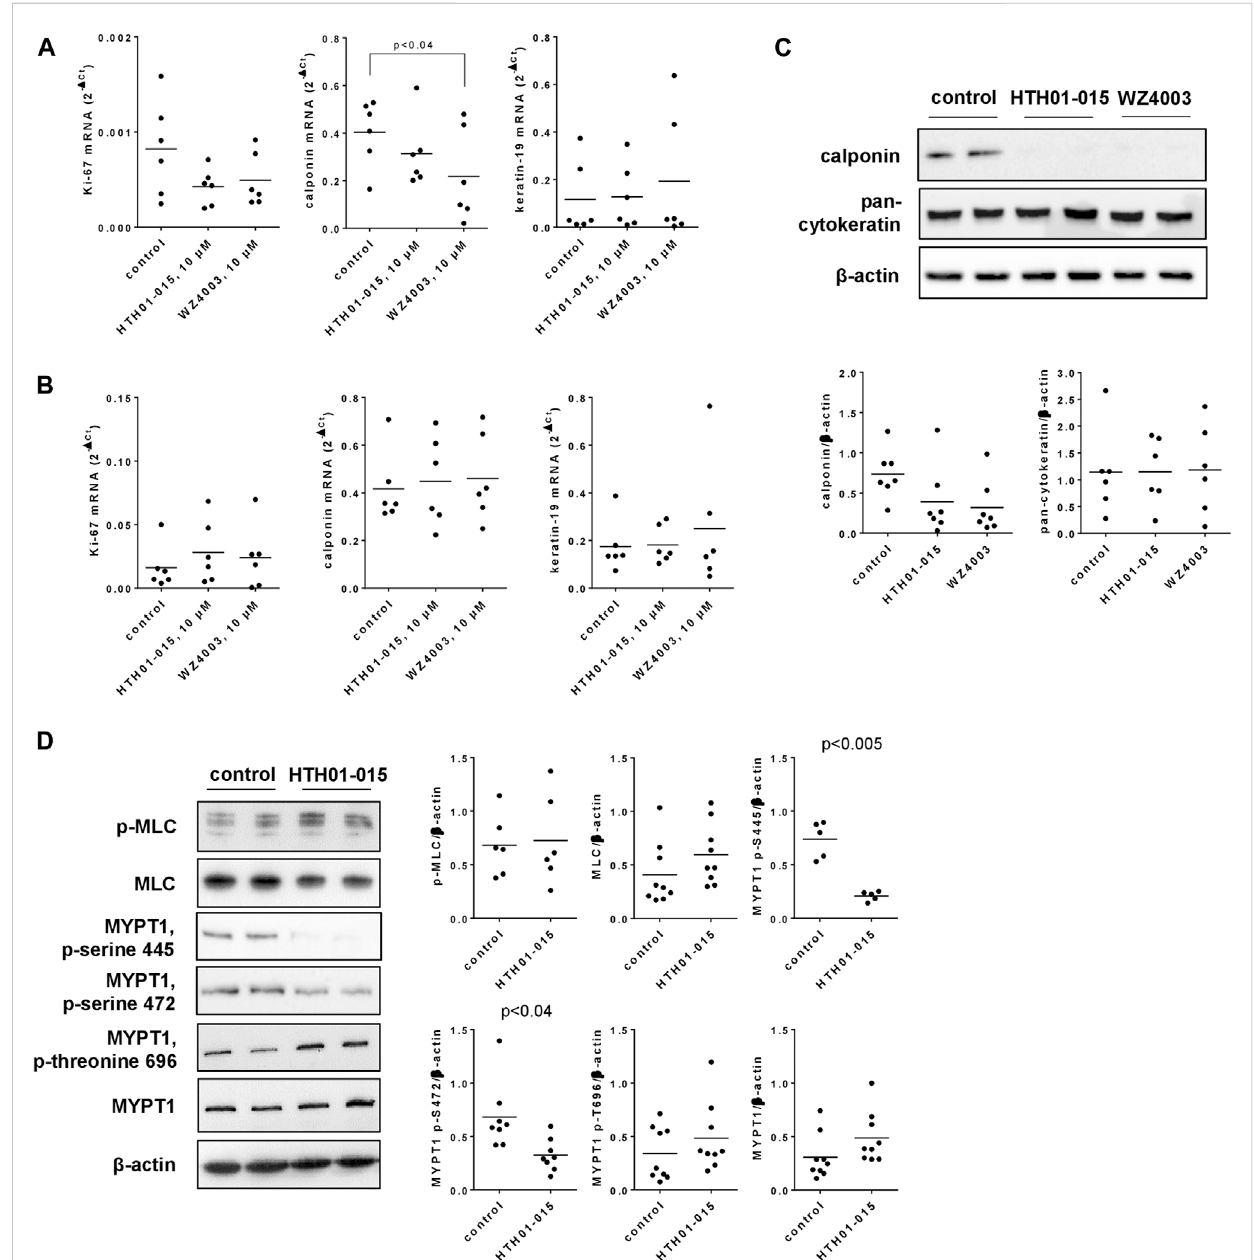
FIGURE 7 EffectsofHTH01-015andWZ4003onmarkerexpression,andonMYPT/MLCphosphorylationsinhumanprostatetissues.RT-PCRforKi-67(marker for proliferation), calponin (marker for smooth muscle cells) and cytokeratin-19 (marker for glandular epithelial cells) was performed after incubation of human prostate tissues with HTH01-015 WZ4003 (both 10 µM) or solvent for controls for 22 h together with 50 nM DHT (in all samples) (A) or 5 h (B) . Westernblotanalysesforcalponinandpan-cytokeratinwereperformedafterincubationofhumanprostatetissueswithHTH01-015,WZ4003(both 10 µM) or solvent for controls for 22 h (C) . Western blot analyses for phosphorylated and non-phosphorylated MLC and MYPT1 were performed after incubation of human prostate tissues with HTH01-015 (500 nM) or solvent for controls for 30 min (D) . Shown are scatter plots including all single values from quanti fi cation of each independent experiment together with p values from one-way ANOVA with Dunnett ’ s test in (A) , and Student ’ s t -test in (D) , and representative Western